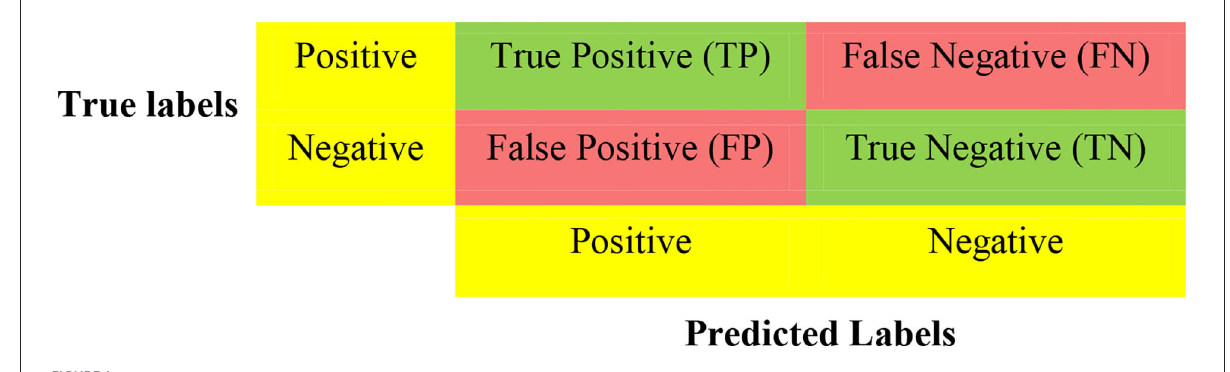
FIGURE1 Confusion matrix.